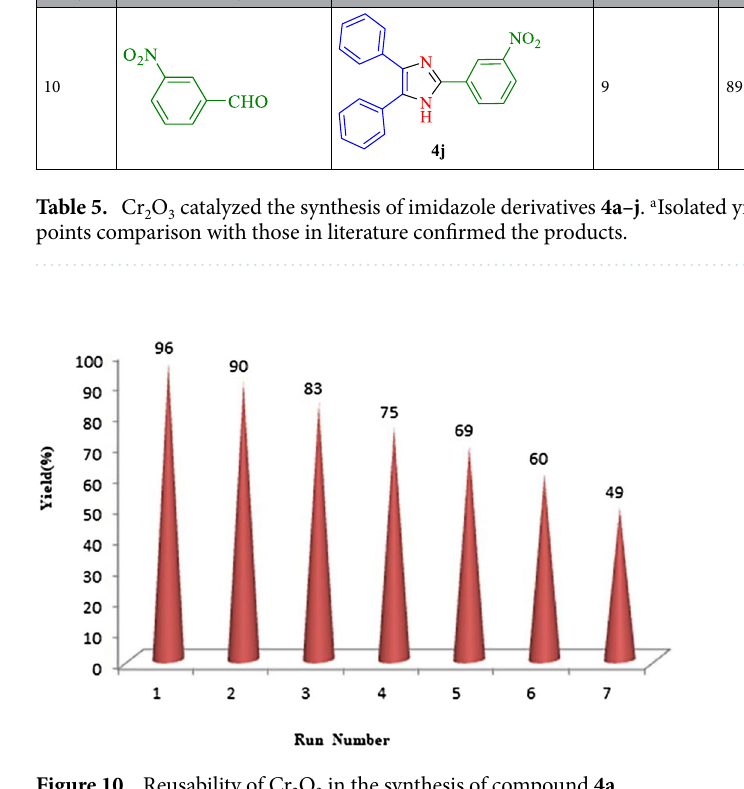
Figure 10. Reusability of Cr 2 O 3 in the synthesis of compound 4a .